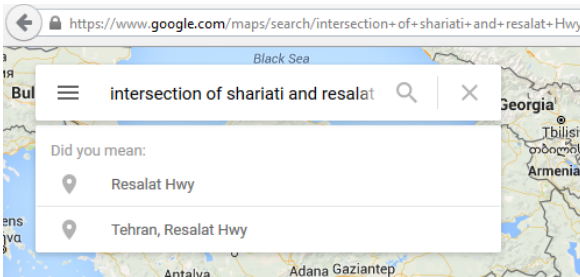
Figure 1 the query which responded quietly wrong by the Google